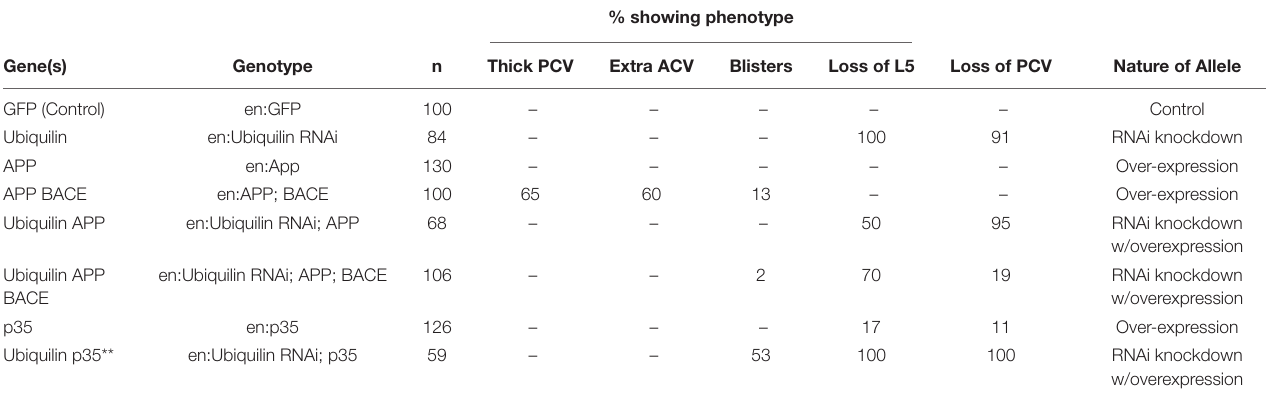
TABLE 1 | Genetic Interaction between Ubiquilin, APP, BACE, and